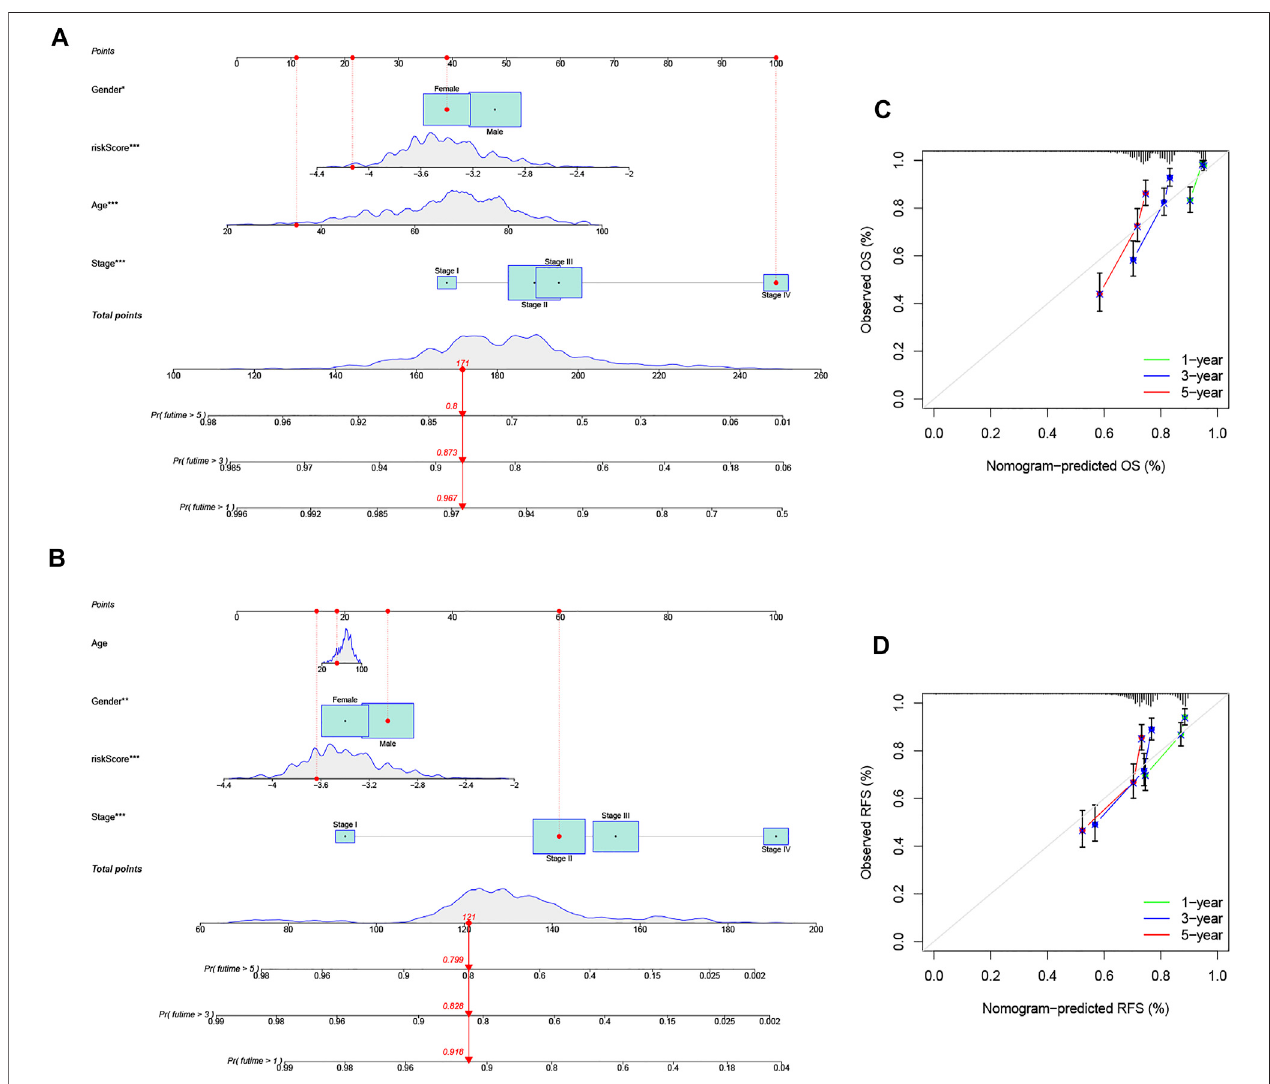
FIGURE 7 | Construction and evaluation of a predictive nomogram. (A) Nomogram predicts the probability of OS at 1, 3, and 5 years. (B) Nomogram predicts the probability of RFS at 1, 3, and 5 years. (C) Calibration plot of the nomogram predicts the probability of the 1-, 3-, and 5-year OS. (D) Calibration plot of the nomogram predicts the probability of the 1-, 3-, and 5-year